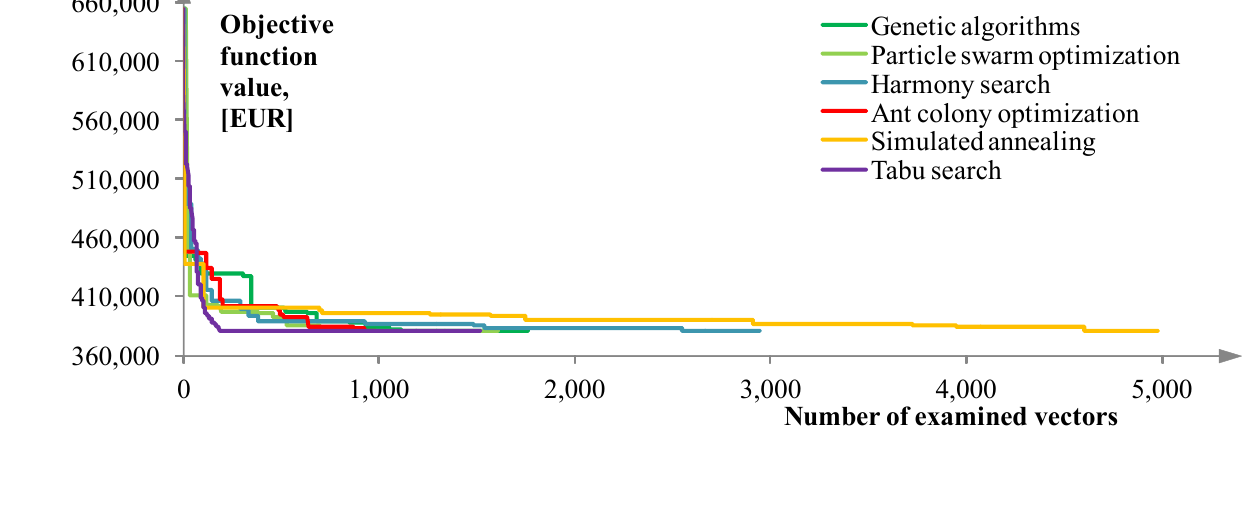
Figure 6. Convergence towards minimal annual total costs with the examined